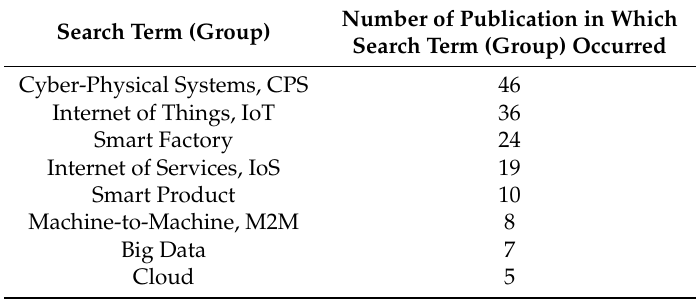
Table 1. Core technologies of Industry